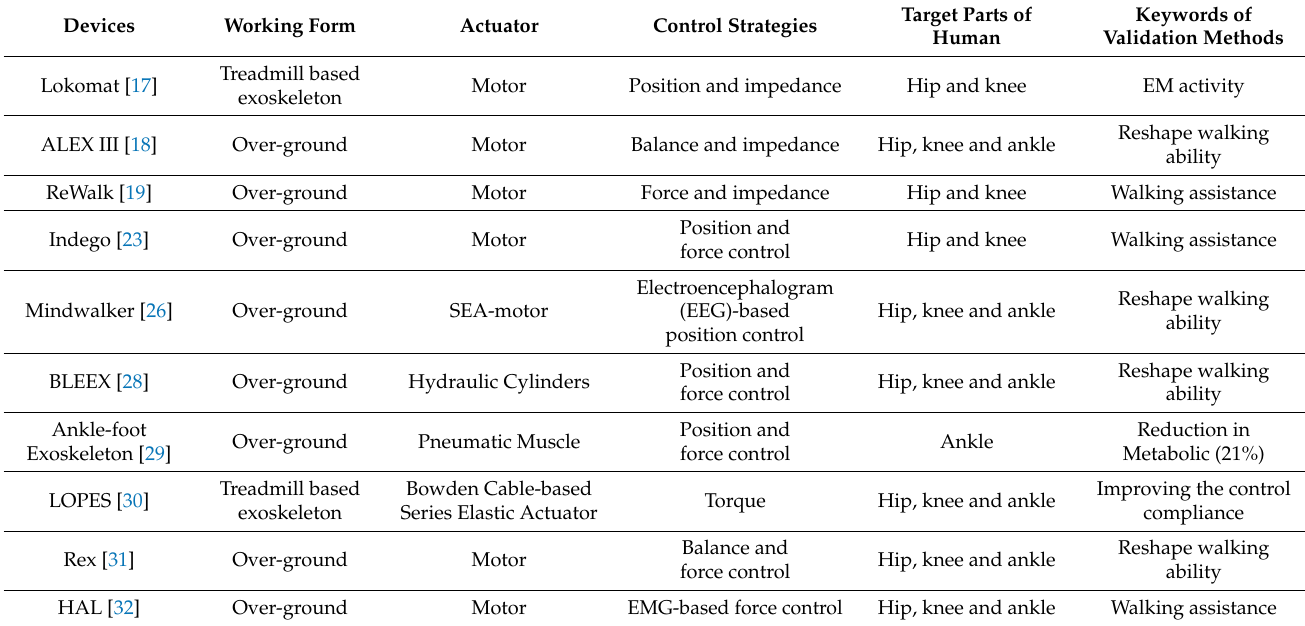
Table 1. Summary of existing exoskeletons and their related technical details (treadmill-based exoskeletons: The man–machine system operates on the treadmill. Over-ground: The man-machine system can operate on the